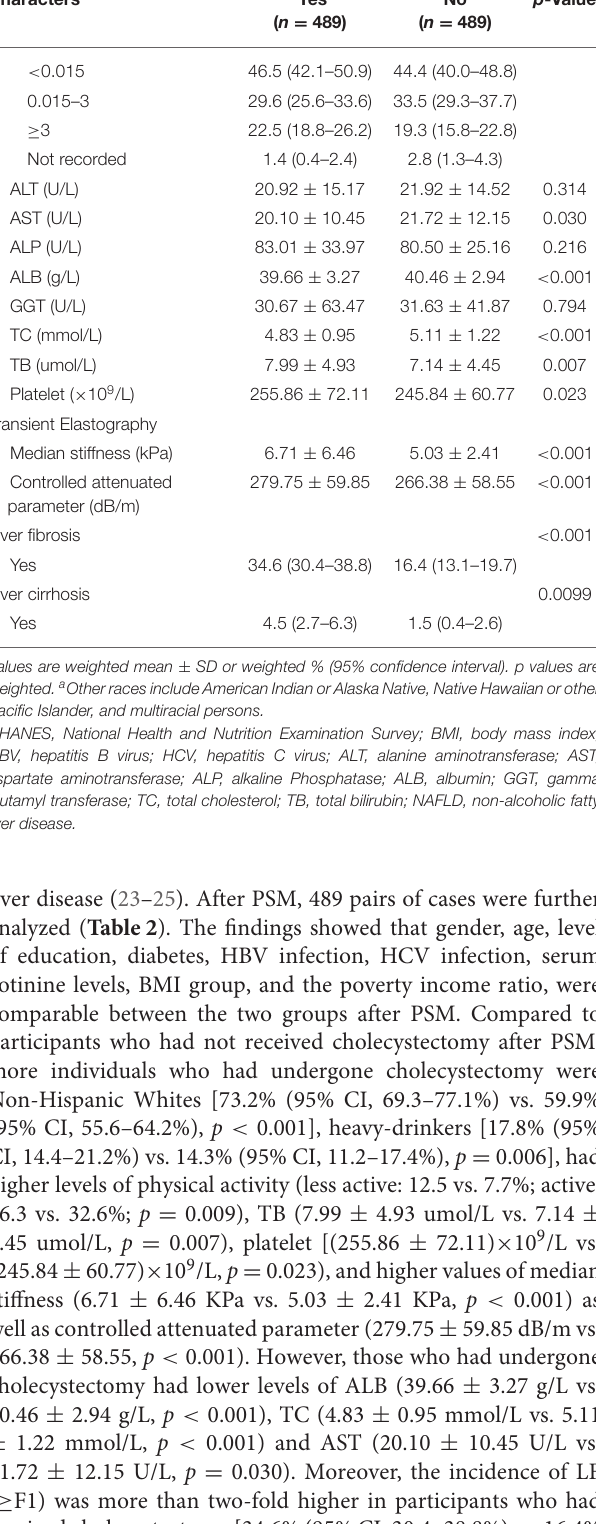
TABLE 2 | General characteristics of participants ( n = 978) by the presence or absence of a history of cholecystectomy after propensity score matching in the NHANES